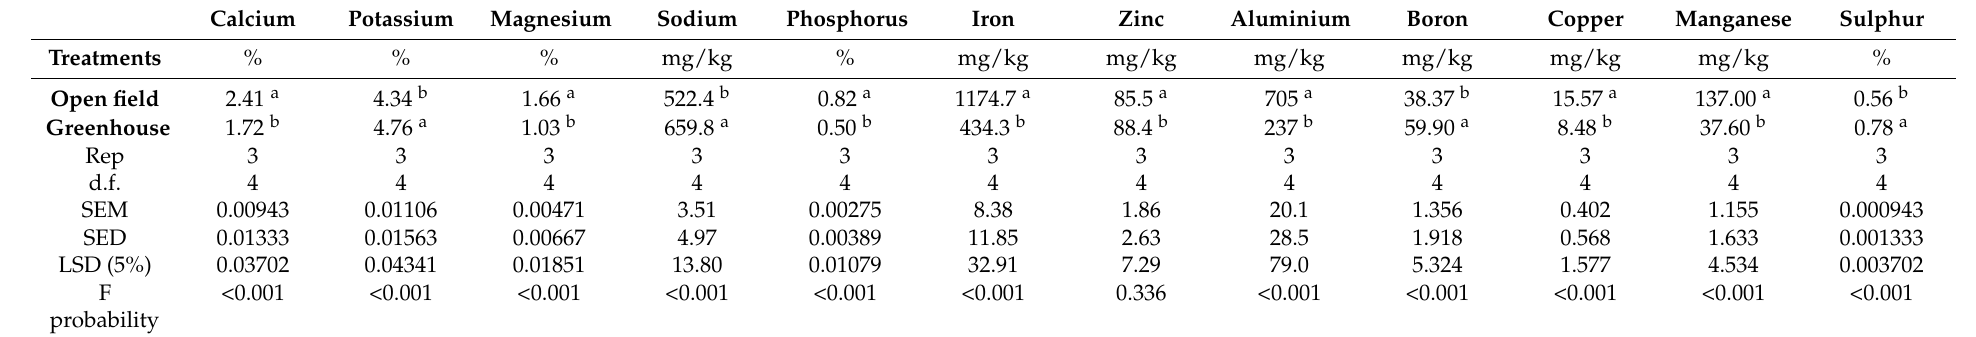
Table 5. Comparison of minerals composition of amaranth leaves A. Graecizans L. in the open field vs. greenhouse on a dry weight basis.